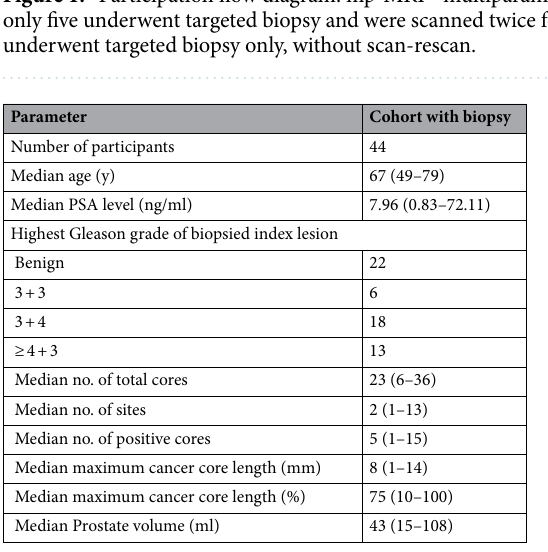
Table 1. Summary of demographic data. Except where indicated, data are numbers of participants. Numbers in parentheses are ranges. PSA Prostate specific